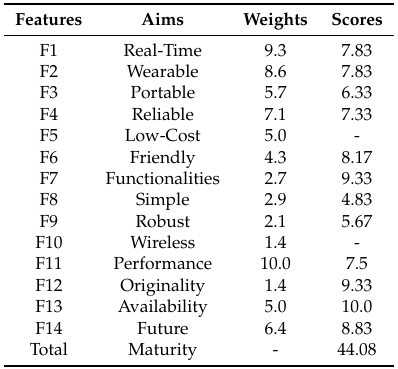
Table 8. Maturity analysis according to